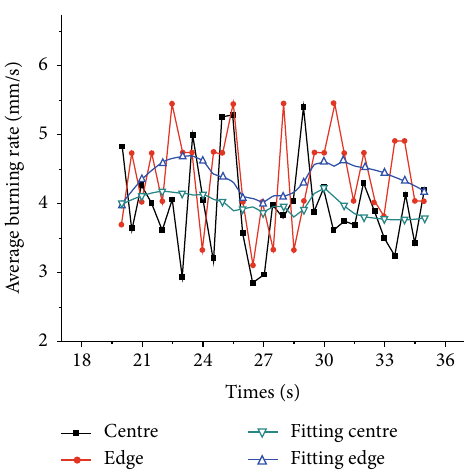
Figure 10: Average burning rates at the center line and the edge from 20s to 36s for